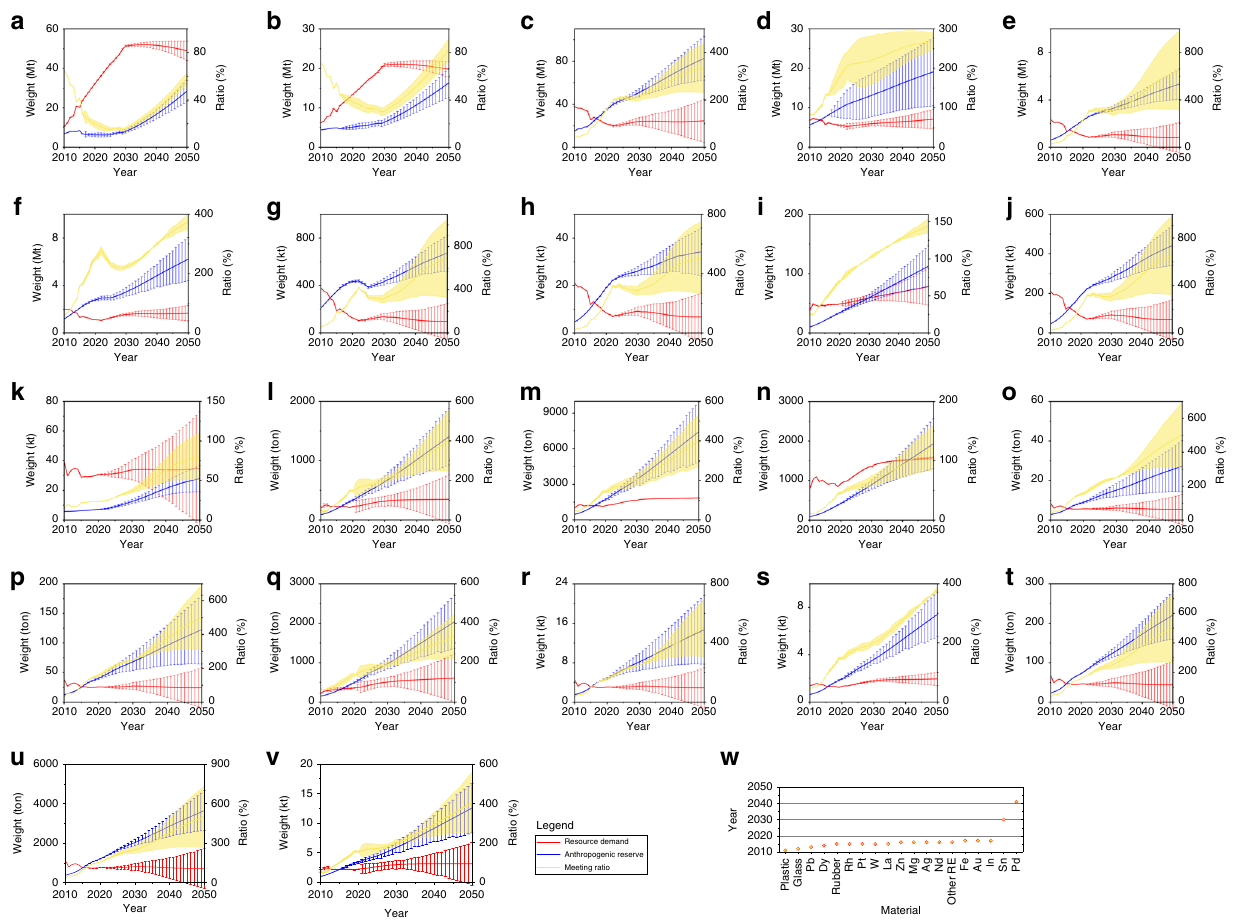
Fig. 5 Meeting potential of AM for resource consumption of three product groups. a Cu. b Al. c Fe. d Plastic. e Rubber. f Glass. g Pb. h Zn. i Sn. j Mg. k Co. l Au. m Ag. n Pd. o Rh. p Pt. q In. r W. s Nd. t Dy. u La. v other RE. w Meeting time of various materials. Meeting ratio is the value of anthropogenic mineral dividing resource consumption. The shade of light yellowish-brown indicates the range of recycling potential. Rank of various materials is based on the value of meeting time, which is the year while the meeting ratio equals